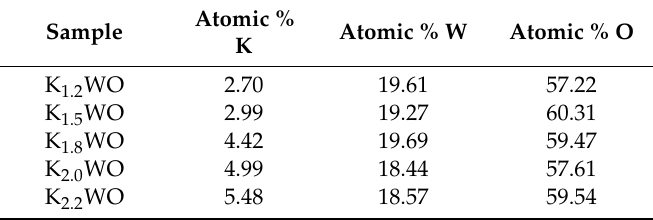
Table 1. Atomic make up of K x WO obtained from XPS. Atomic % Sample Atomic % K